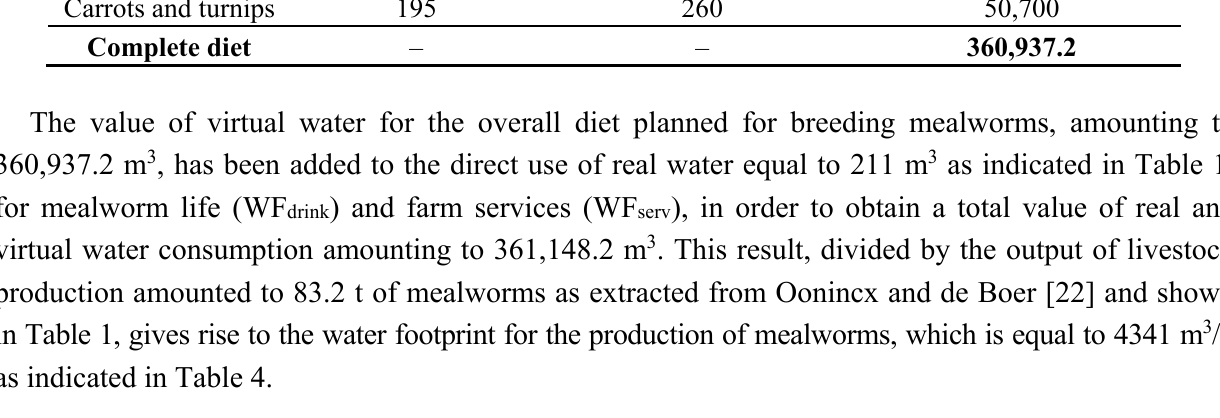
Table 4. Virtual water consumption of the farmed insect